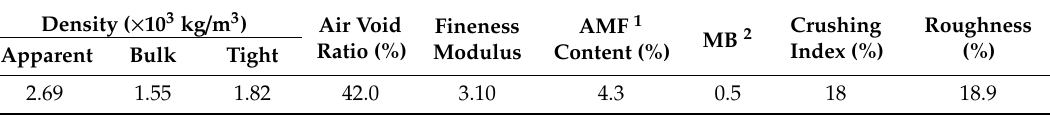
Table 1. Properties of machine-made